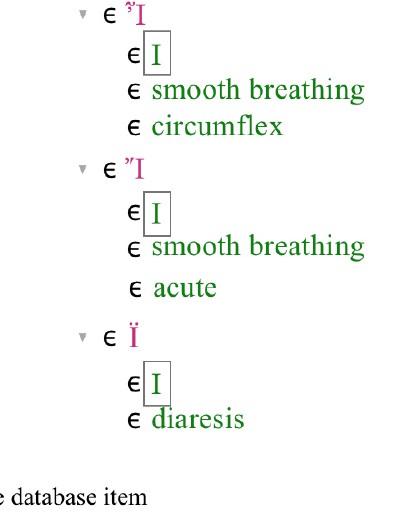
Figure 5: Reuse of database items in multiple combining characters Atomization also allows comparison between manuscripts with diacritics and manuscripts without, while still avoiding duplication of character strings. We can use the iota in Figure 5 to encode a Greek manuscript that attests no diacritics at all by adding the iota alone to that manuscript’s hierarchy, leaving the diacritics behind. The reuse of the database item creates alignment between that unaccented iota and any of the accented